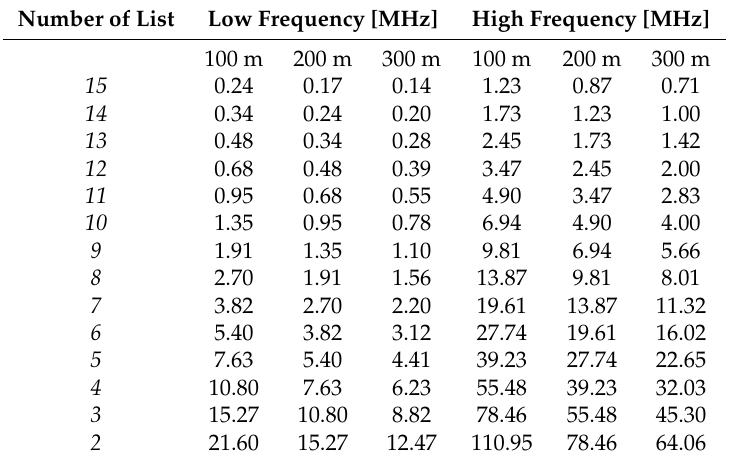
Table 2. Low and high frequencies to transmit l bits per sub-carrier for n I = 15.